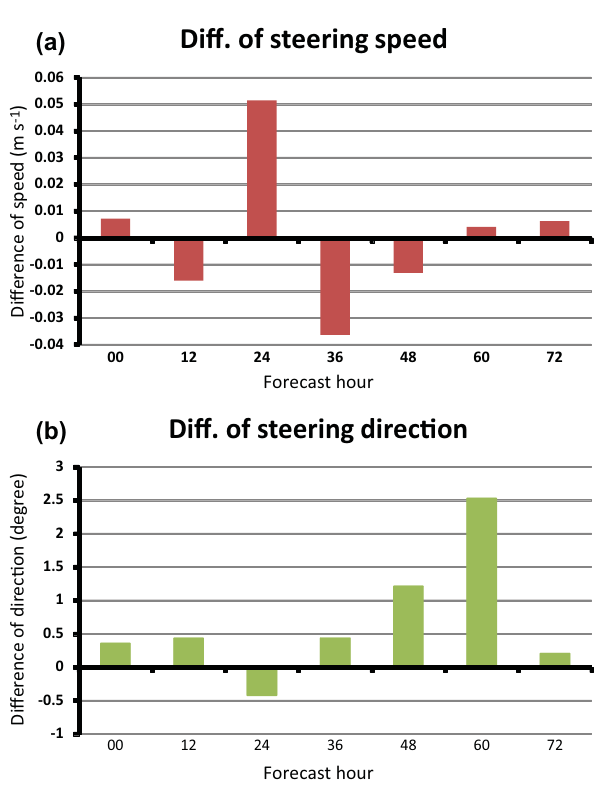
Figure 10. Difference of absolute error (against the steering flow derived from analysis of ECMWF) on steering flow (a) speed and (b) direction between PNG and PWG.